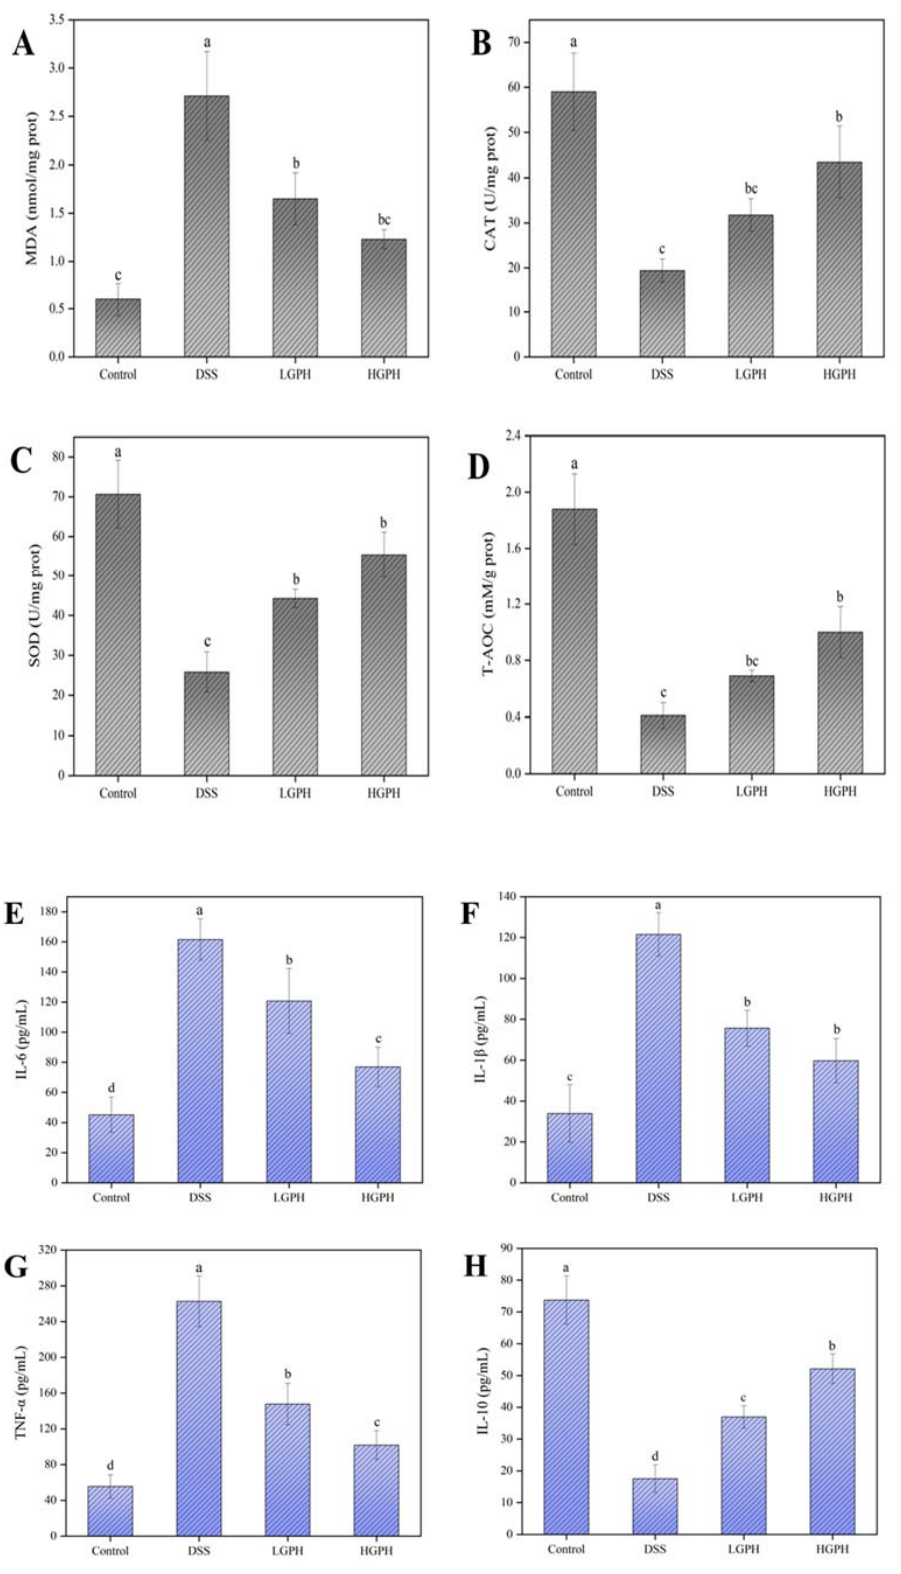
Figure 3. GPH extracts protected colon from oxidative stress and improved the inflammatory status in DSS-induced UC mice. ( A ) MDA; ( B ) CAT; ( C ) SOD; ( D ) T-AOC; ( E ) IL-6; ( F ) IL-1 β ; ( G ) TNF- α ; ( H ) IL-10. Values not sharing a common superscript letter denote significant difference ( p < 0.05).